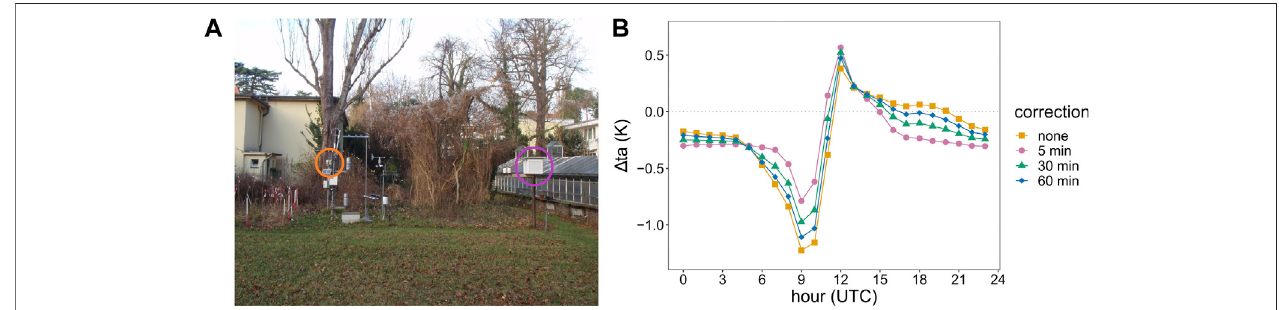
FIGURE9|(A) SetupofthecomparisonmeasurementsbetweenoneNetatmoCWS, fi xedinawoodenStevensonScreen(purple)andareferencesensor(orange) in Berlin at site Rothenburg (52.4572 ° N, 13.3158 ° E) during 2015. (B) Mean diurnal cycle of air-temperature difference ( Δ ta ) between the Netatmo outdoor module and the reference sensor during 2015. The yellow line (squares) corresponds to the mean data as shown by Meier et al. (2017). Netatmo data at the original temporal resolution( ∼ 5 min)wascorrectedusingatime-constantvalueof1480.5 sandtheformulain OptionalQuality-ControlLevels section.Thecorrectionwasappliedat different temporal resolutions (original/5, 30, 60 min). Afterwards, all data were aggregated to hourly mean values and the hourly mean values of the PRWS